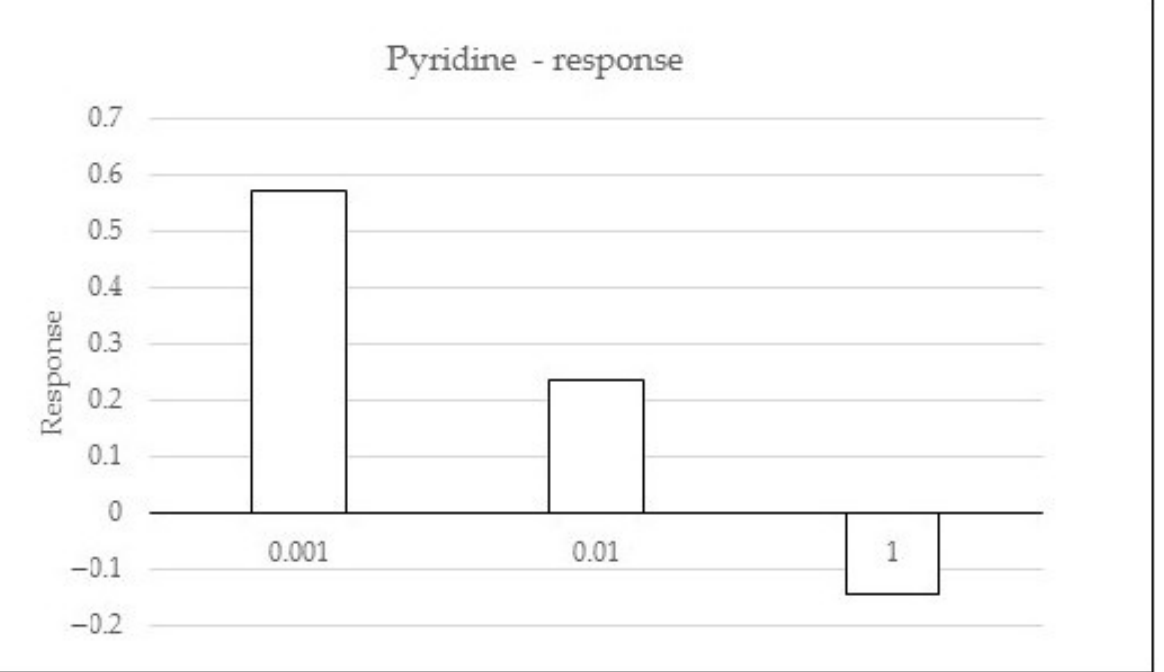
Figure 3. Response of Drosophila hydei to pyridine in three concentrations (%) as compared with the control.